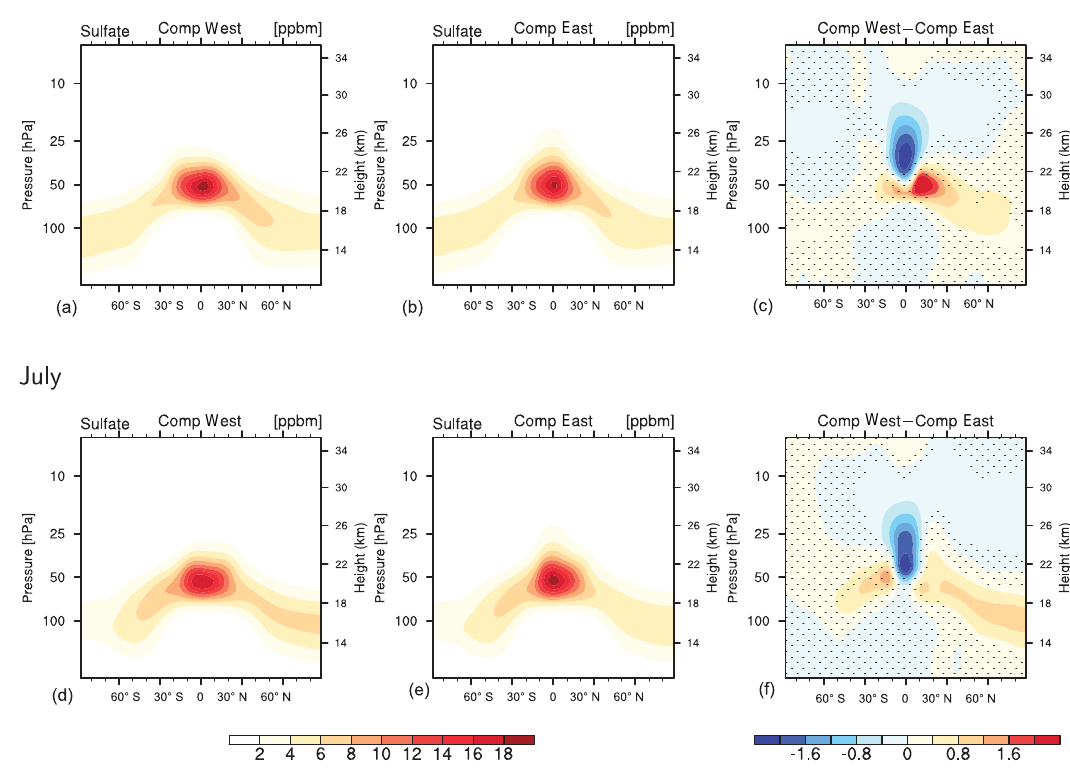
Figure 4. Zonal mean of sulfur mass mixing ratio [ppbm] for 4Tg ( S ) yr − 1 injected at 60hPa for Composite West (a, d) , Composite East (b, e) and difference of Composite W–Composite E (c, f) for January (a–c) and July (d–f) . Stippling indicates areas which are not significant at the 95%